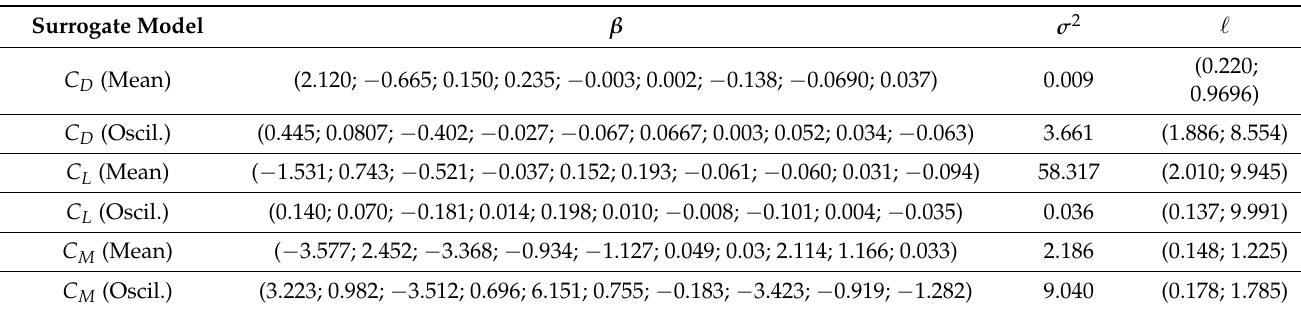
Table A2. Estimated parameters of the Gaussian process-based surrogate